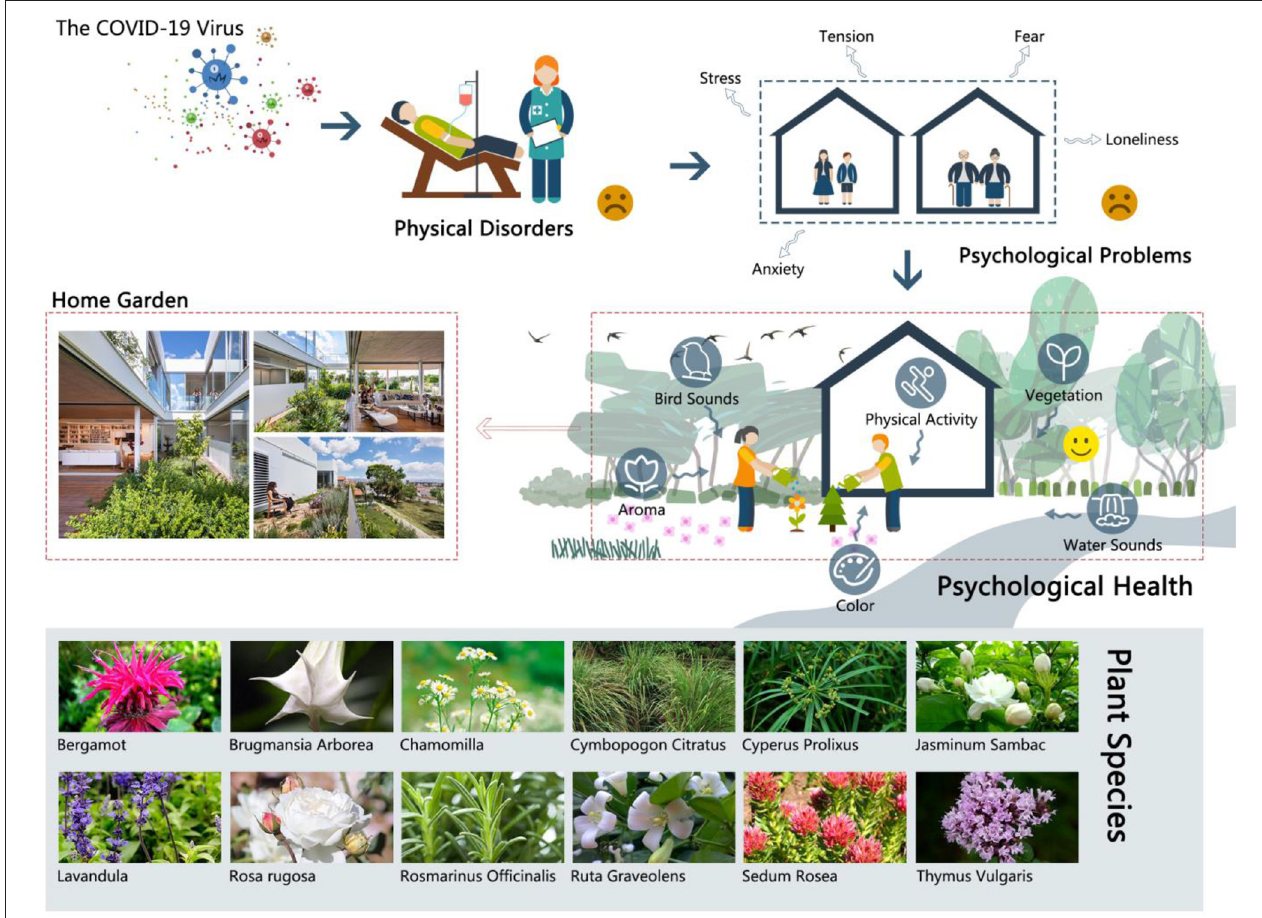
FIGURE 3 | The diagram shows the mechanisms of “ecological medicine” in which the logical framework is discussed in Figure 1 . And the diagram also shows some plant species in a home garden for mental health. The government gives stay-at-home advisories or shelter-in-place policies in order to control the spread of the COVID-19 pandemic. However, people will feel stress, tension, fear, anxiety, and loneliness due to isolation from society. A home garden, a kind of green space, can improve mental health through natural sounds (birds sounds or water sounds), aroma, color, and vegetation, and it can also benefit biodiversity through more kinds of plants and animals. What is more, it can also increase the frequency of physical activity, such as home gardening, which can give people opportunities to get in contact with nature and release mental stress to improve mental health, as well as benefit biodiversity conservation. The benefits of these can be summarized into three stages: restoration (attention restoration, stress recovery, and increasing physical activity), maintenance (higher quality of green space and residential environment can potentially maintain mental health), and protection (home garden as a buffer between human and harm from the environment). And the pathway of this is called “ecological medicine” which is a kind of nature-based solution. Image (left-down picture of a home garden): https://mooool.com/the-garden-house-in-